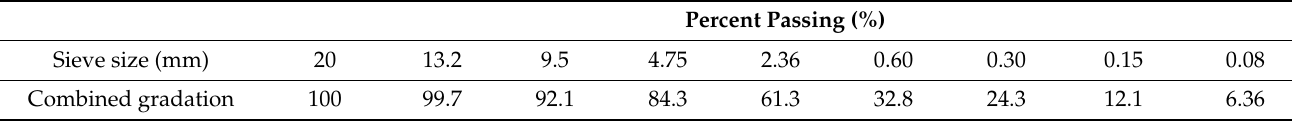
Figure 5. Particle size distribution of aggregate. Table 5. Particle size distribution of aggregate in recycled asphalt mixture.